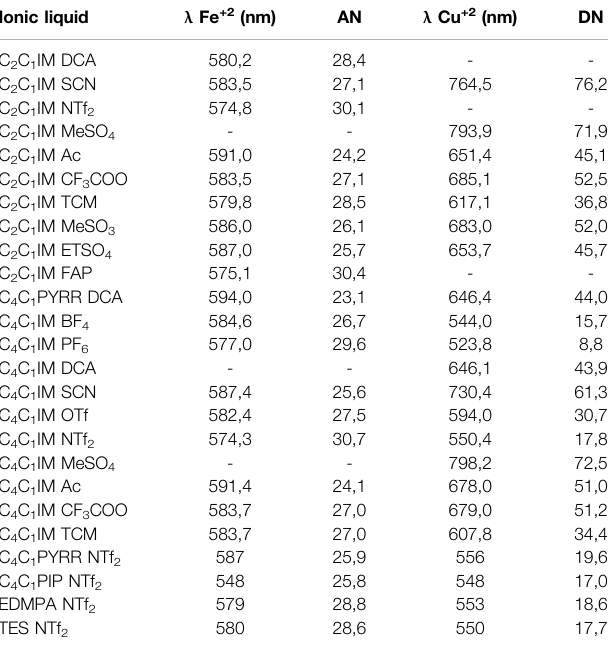
TABLE 1 | Solvatochromic shifts of the Fe +2 and Cu +2 dyes and their respective Gutmann numbers for a series of ionic liquids. Ionic